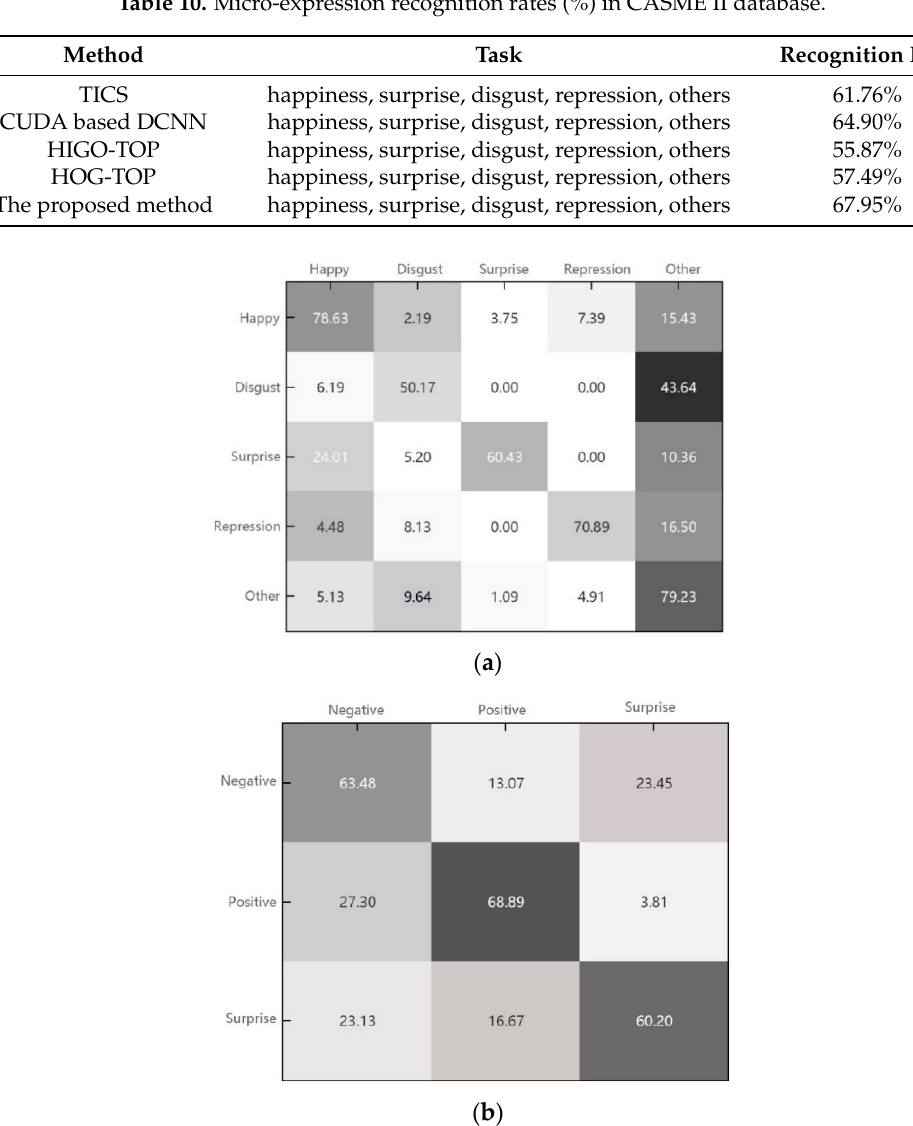
Figure 8. Confusion matrix for micro-expression recognition ( a ) Recognition rate of all emotion types on CASME II database ( b ) Recognition rate of all emotion types on SMIC database.